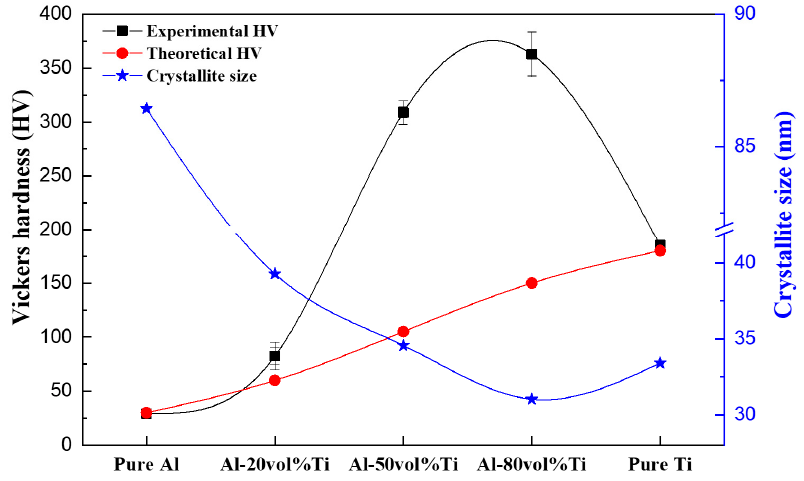
Figure 10. Vickers hardness and crystallite sizes of Al, Ti, and Al-Ti composites.